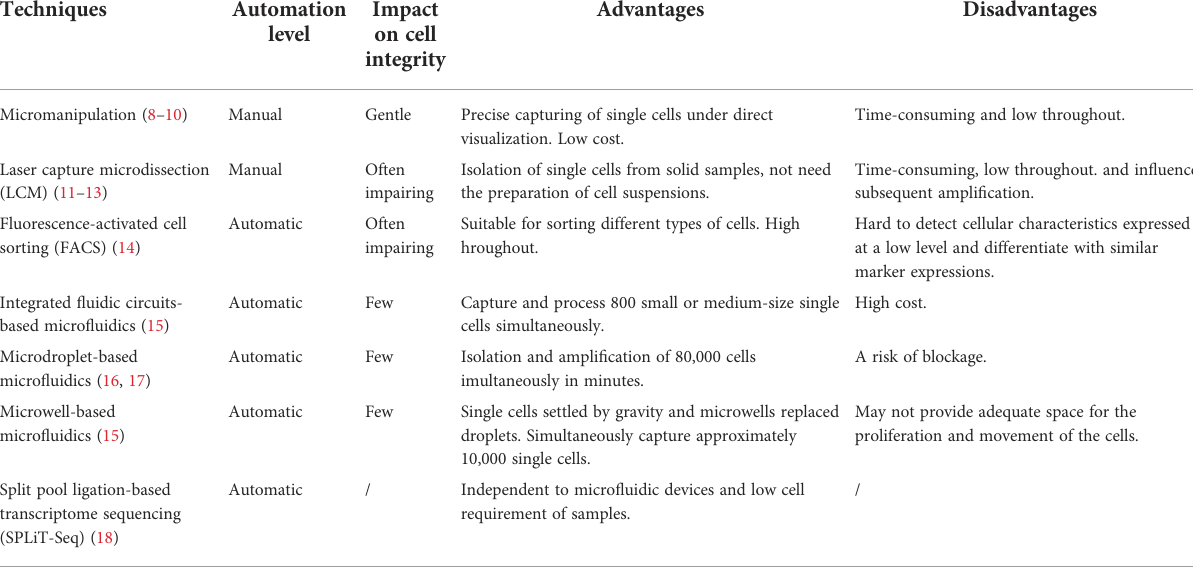
TABLE 1 Comparison of the advantages and disadvantages of single-cell isolation methods.